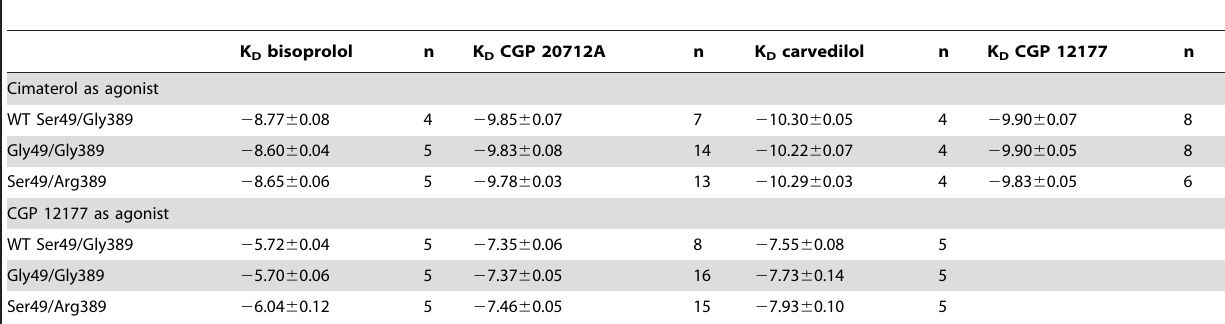
Table 3. Affinity of antagonists for the two agonist conformations of the wildtype and polymorphic variants of the b 1-